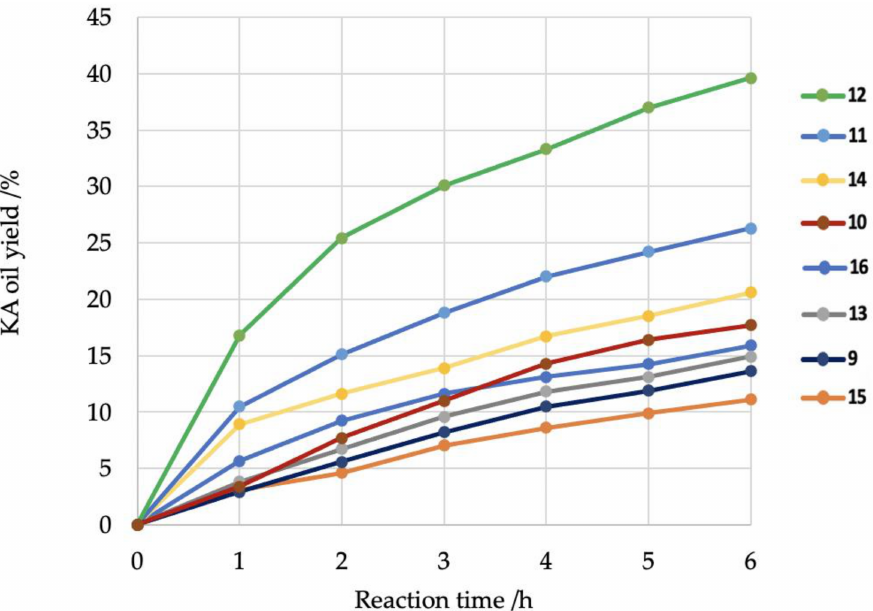
Figure 9. Effect of reaction time on the yield of KA oil obtained by oxidation of cyclohexane catalyzed by complexes 9 – 16 . Optimized mild reaction conditions: catalyst (5 µ mol), cyclohexane (2.5 mmol), tert-butyl hydroperoxide (TBHP) aq. sol. 70% (5.0 mmol), temperature = 60 ◦ C (thermal heating) in ACN (3 mL). %Yield = moles of cyclohexanone + cyclohexanol per 100 mol of cyclohexane (gas chromatography (GC) yield after treatment with PPh 3